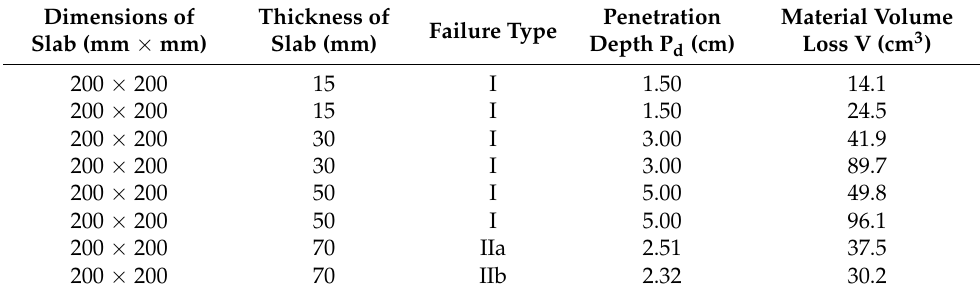
Table 3. Projectile impact results for mixture 2(0-2)/20/6.